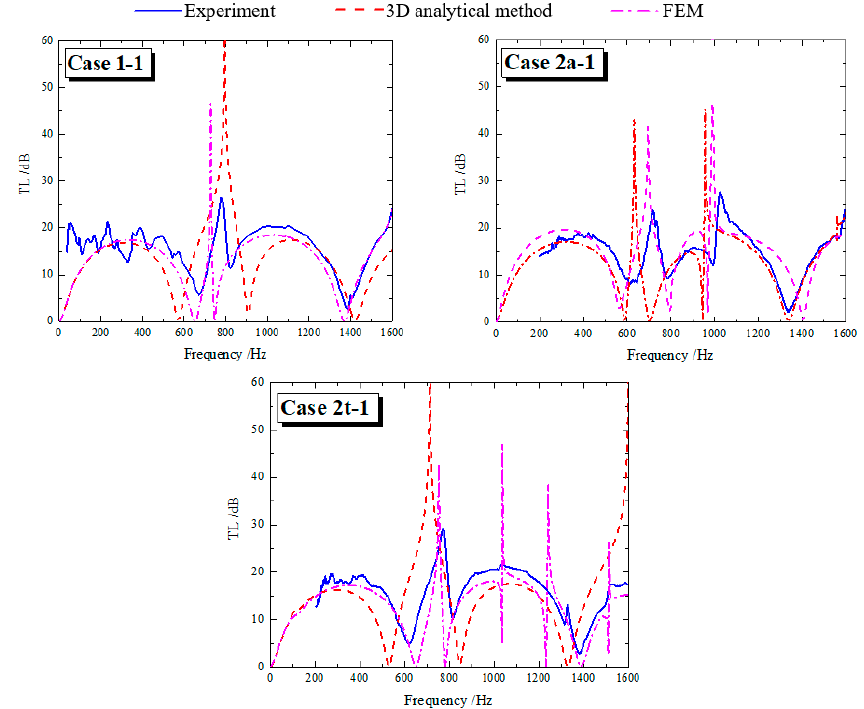
Figure 8. The comparison of TLs obtained by experiment, 3D analytical method and FEM.